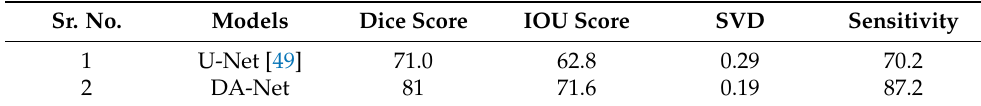
Table 1. Comparative analysis of the proposed model with U-Net. Sr. No.